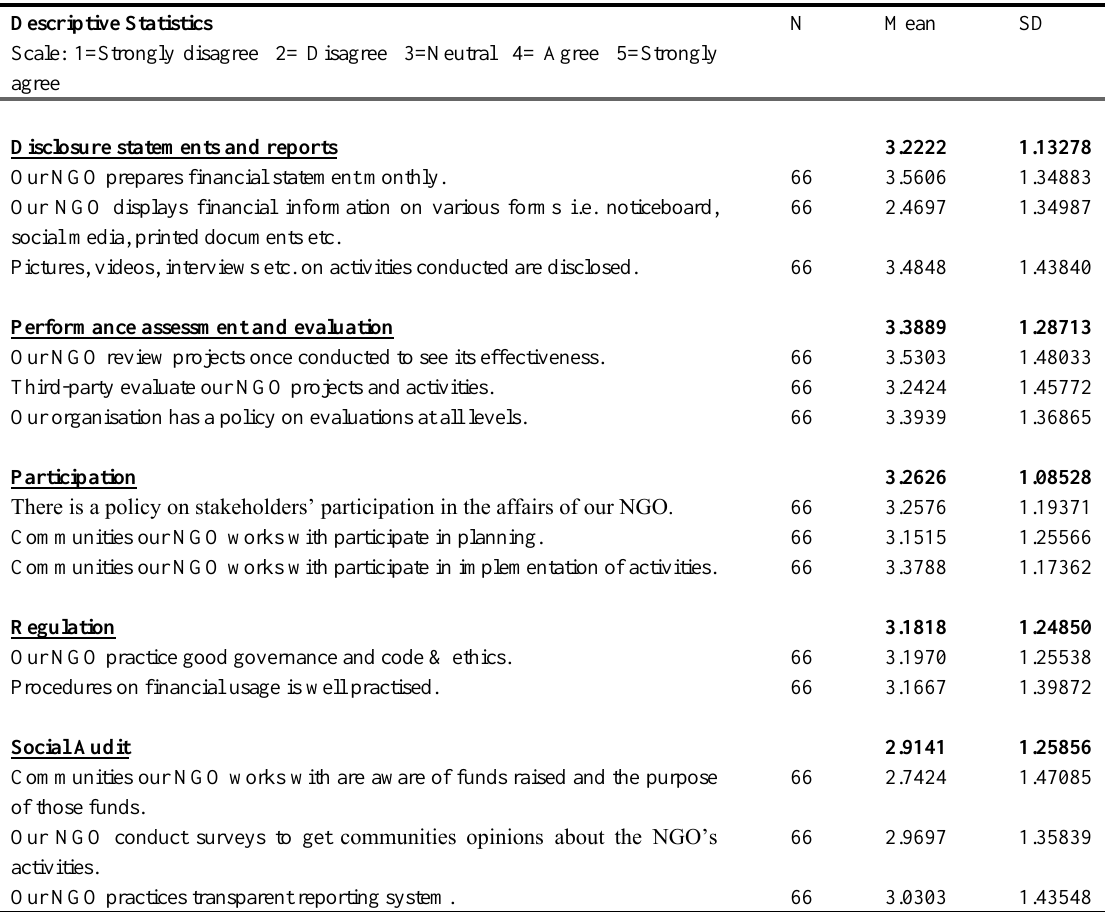
Table 3: Descriptive Statistics for Level of Accountability